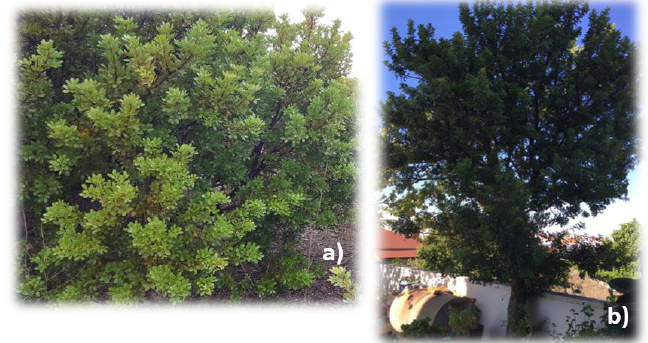
Figure 1. Wild mastic trees in: ( a ) Ovacik Village, Cesme Penunsula; and ( b ) Mordogan, Karaburun Penunsula. Photos courtesy of Mustafa Ozer ( a ) and N.T. ( b ).